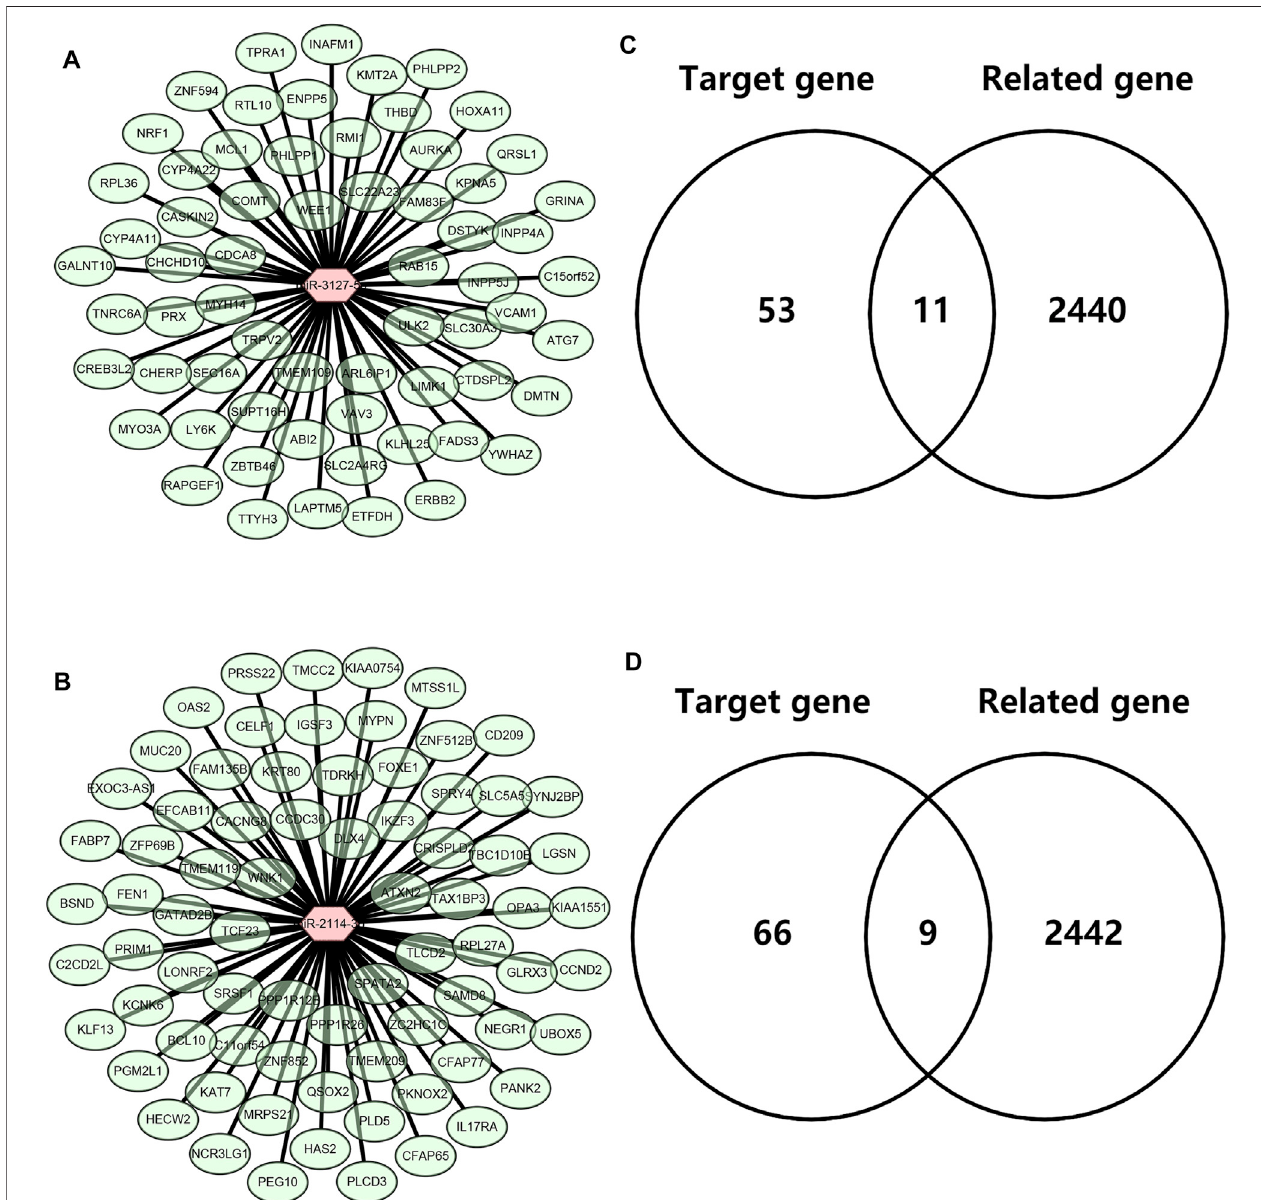
FIGURE6| Identi fi cationofdownstreampotentialtargetsofmiR-3127-5p andmiR-2114-3pinbreastcancer. (A) EstablishmentofamiR-3127-5p-genenetwork. (B) Establishment of a miR-2114-3p-gene network. (C,D) Intersection of predicted target genes of miR-3127-5p (C) or miR-2114-3p (D) and in fl ammation-related genes in breast